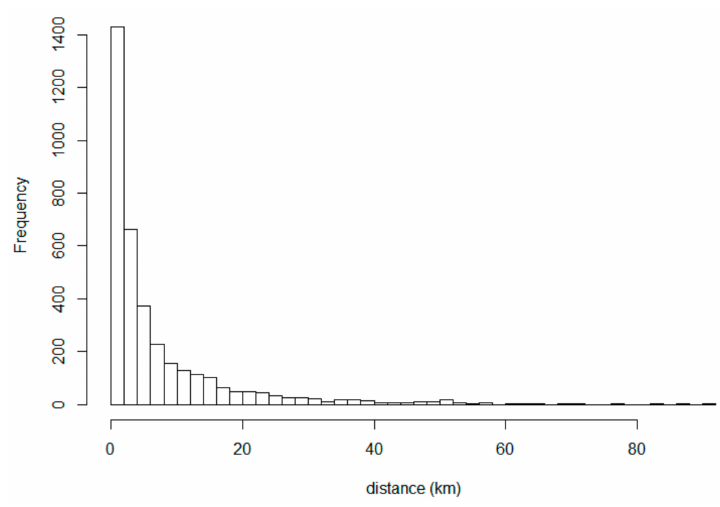
Figure 1. Distribution of journey-to-crime distances of residential burglary trips in ZG City, China. Figures 2 and 3 show the average journey-to-crime distance based on home communities and target communities, respectively. Each point represents the centroid of each community. On the whole, they have similar spatial patterns, that is, most of the short distances are located in the city center and longer distances are located in the north part, east part and south part of the city. However, criminal trips that are longer than 10 km based on the home community have a more dispersed distribution pattern compared to those based at the target community.